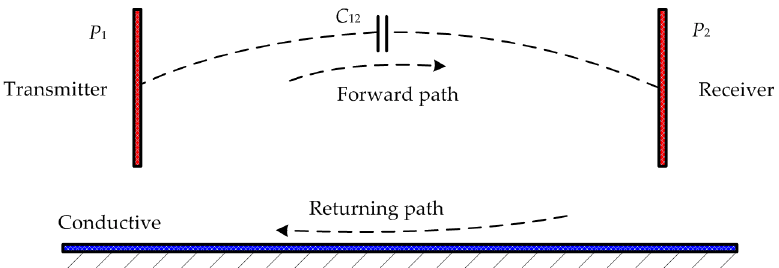
Figure 21. Structure of a two-plate capacitive coupler.